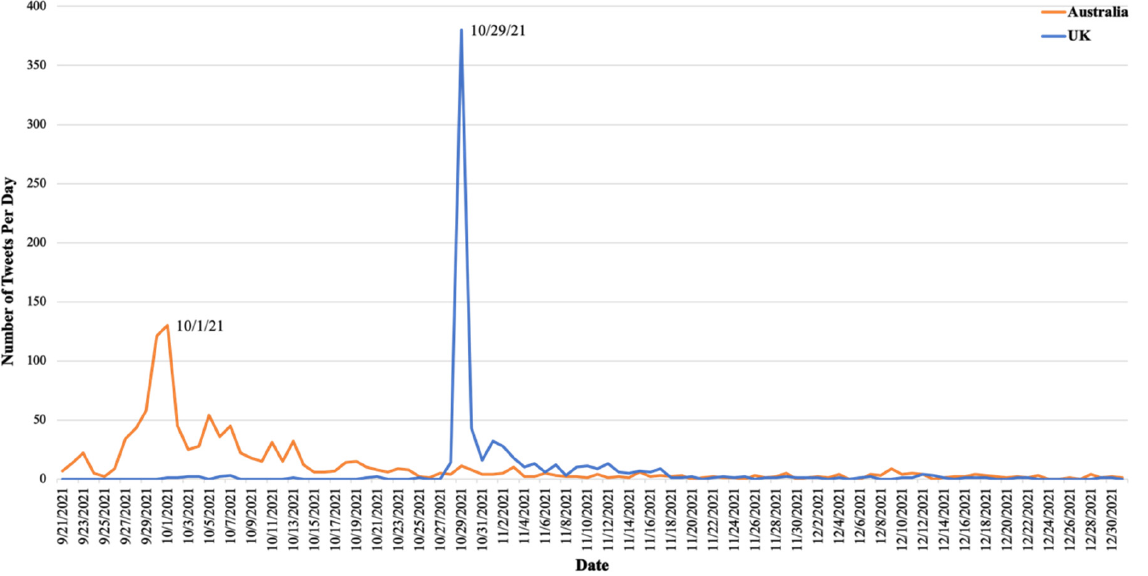
Figure 1. Longitudinal trends of tweets mentioning e-cigarettes as medical products in the UK and Australia.